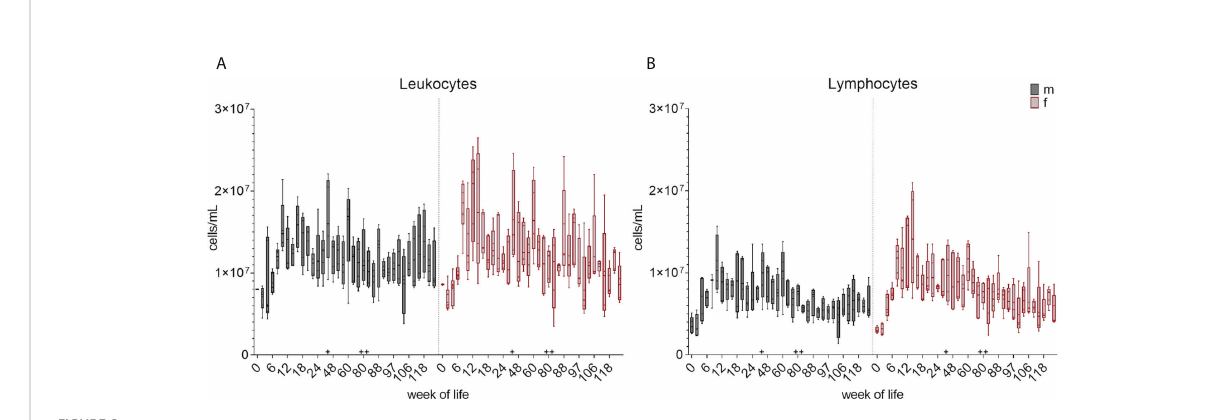
FIGURE 2 Development of total number of leukocytes and lymphocytes from birth to 126 weeks of age. (A) Numbers of leukocytes. Sexes are represented by black (male) and red colors (female). (B) Changes of total numbers of lymphocytes. Separation between the sexes was done as for leukocytes. + marks the fi rst bleeding time point after transfer and vaccination, ++ marks the fi rst bleeding time point after booster vaccinations.